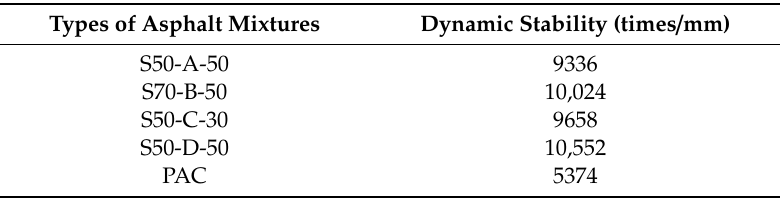
Table 12. Dynamic Stability test results.